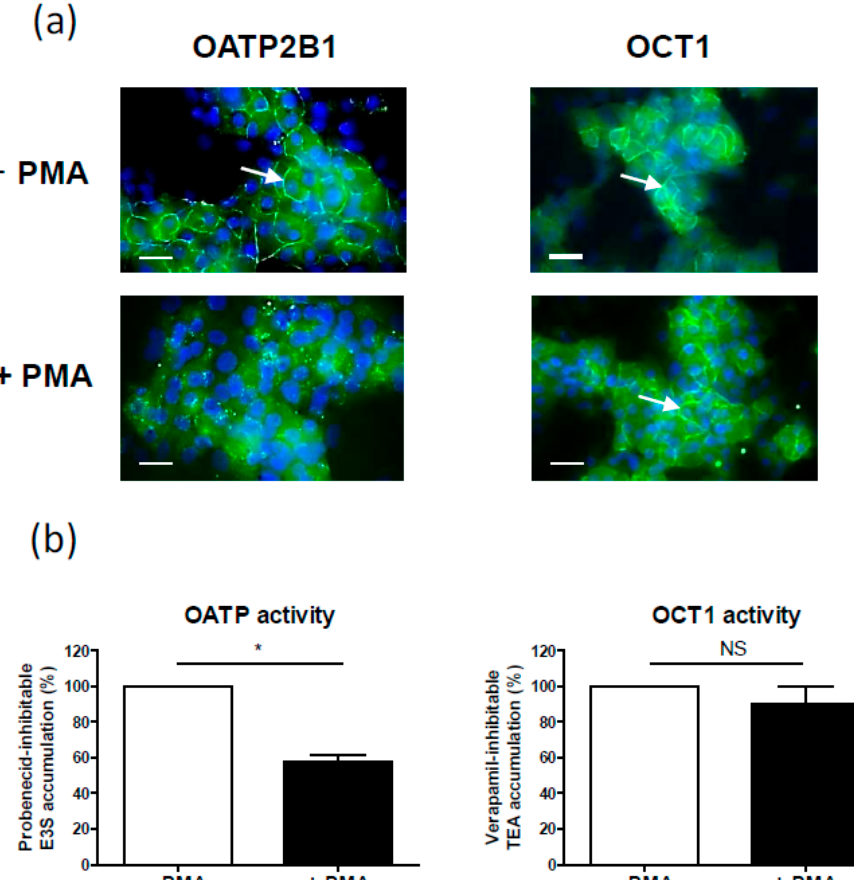
Figure 2. Effect of the protein kinase C (PKC) activator phorbol-12-myristate-13-acetate (PMA) on organic anion transporting polypeptide (OATP) 2B1 and organic cation transporter (OCT) 1 localization ( a ) and activity ( b ) in human highly-differentiated hepatoma HepaRG cells. Human HepaRG cells were exposed or not to 100 nM PMA for 1 h. ( a ) OATP2B1 and OCT1 expression were next analyzed by immunofluorescence as previously reported [129]. Green fluorescence corresponds to transporter immunolabeling, whereas blue fluorescence reflects 4,6-diamidino-2-phenylindole-stained nuclei. Arrows indicate transporter-related sinusoidal membrane fluorescence. Bar = 10 µm; ( b ) Probenecid-inhibitable uptake of estrone-3-sulfate (E3S), reflecting OATP activity [124], and verapamil-inhibitable uptake of tetraethylammonium (TEA), reflecting OCT1 activity [124], were determined as previously described [129]. Data are expressed as % of transporter activity found in cells not exposed to PMA, arbitrarily set at 100%. They are the means ± standard errors of the means (SEM) of at least three independent assays. * p < 0.05 and NS, not statistically significant (Student’s t test).